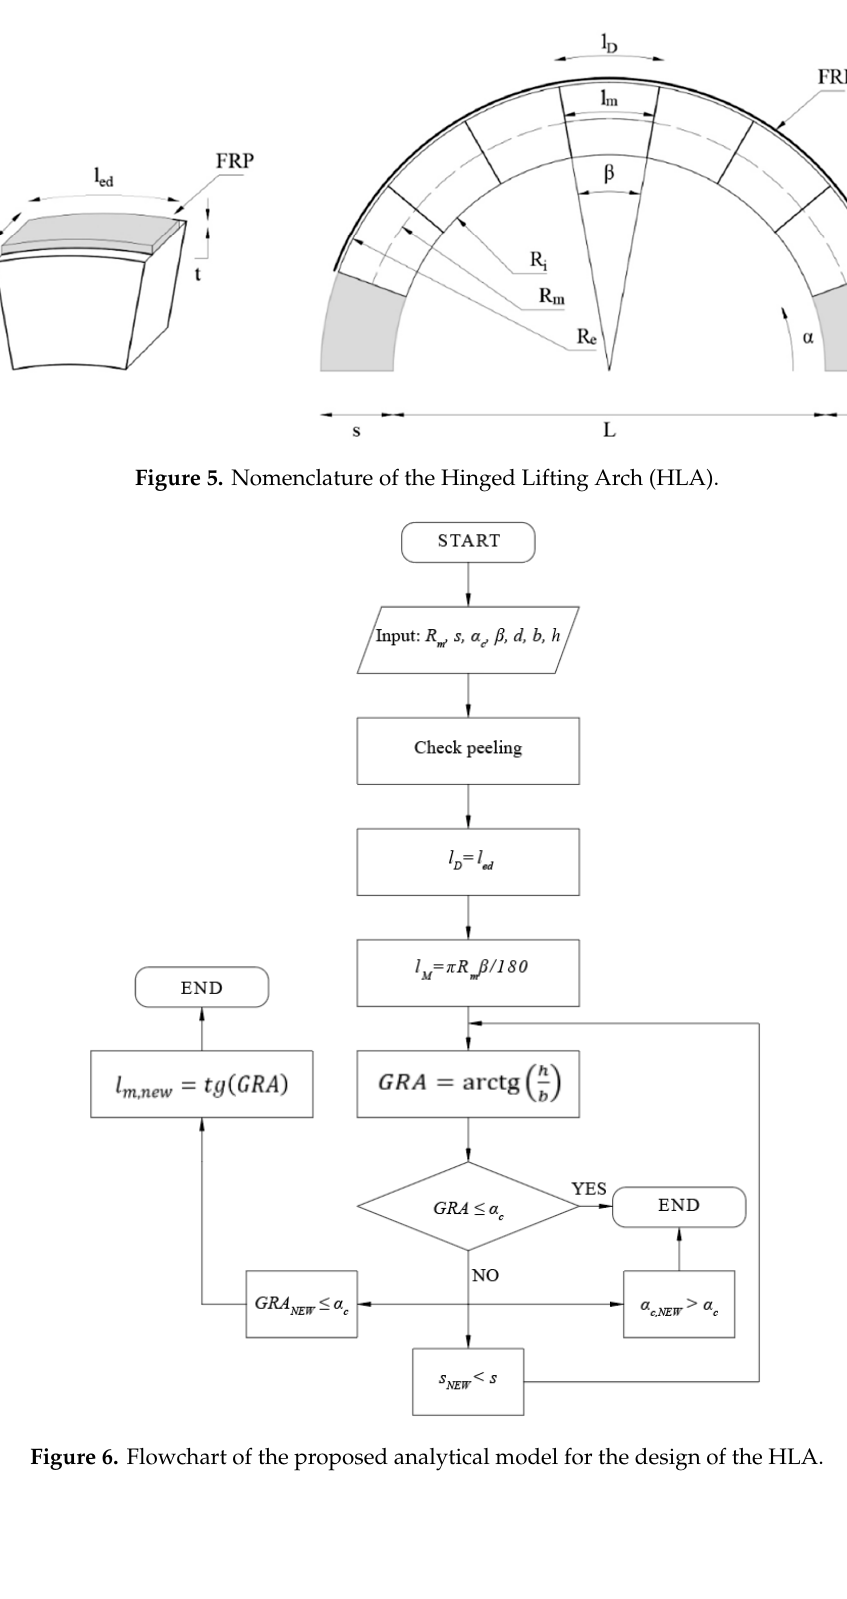
Figure 4. Correlation between the Gravity Rotation Angle (GRA) and the aspect ratio of the block.